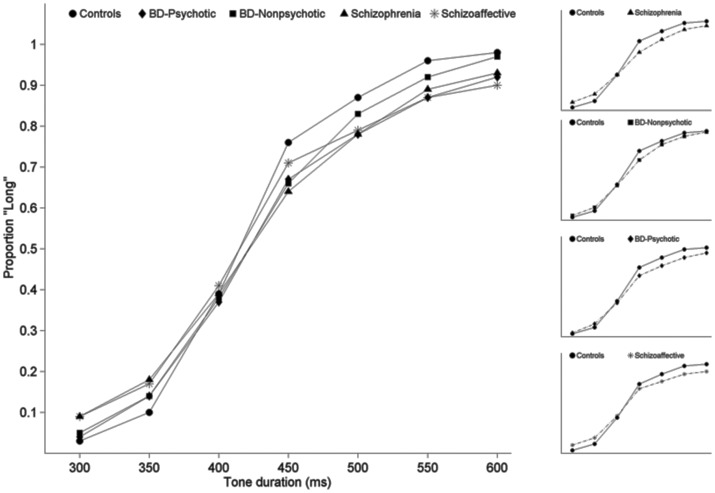
Psychometric response curves for each group composed of the proportion of long responses as a function of signal duration.Smaller insets to the right show each clinical group individually as compared to the control group.